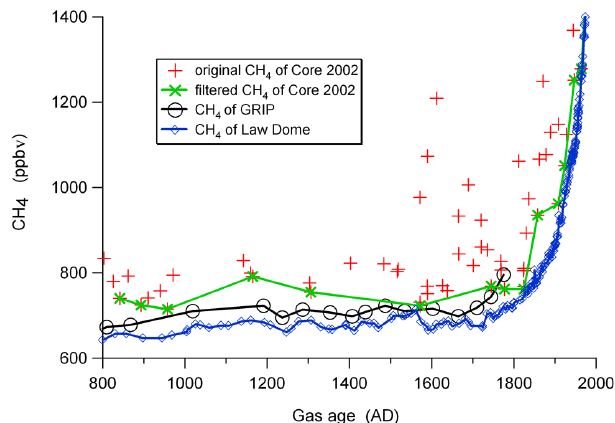
Fig. 3. The background CH 4 profiles of Core2002 with compari- son to the GRIP (Chappellaz et al., 1997) and Law Dome ice core (MacFarling-Meure et al., 2006)